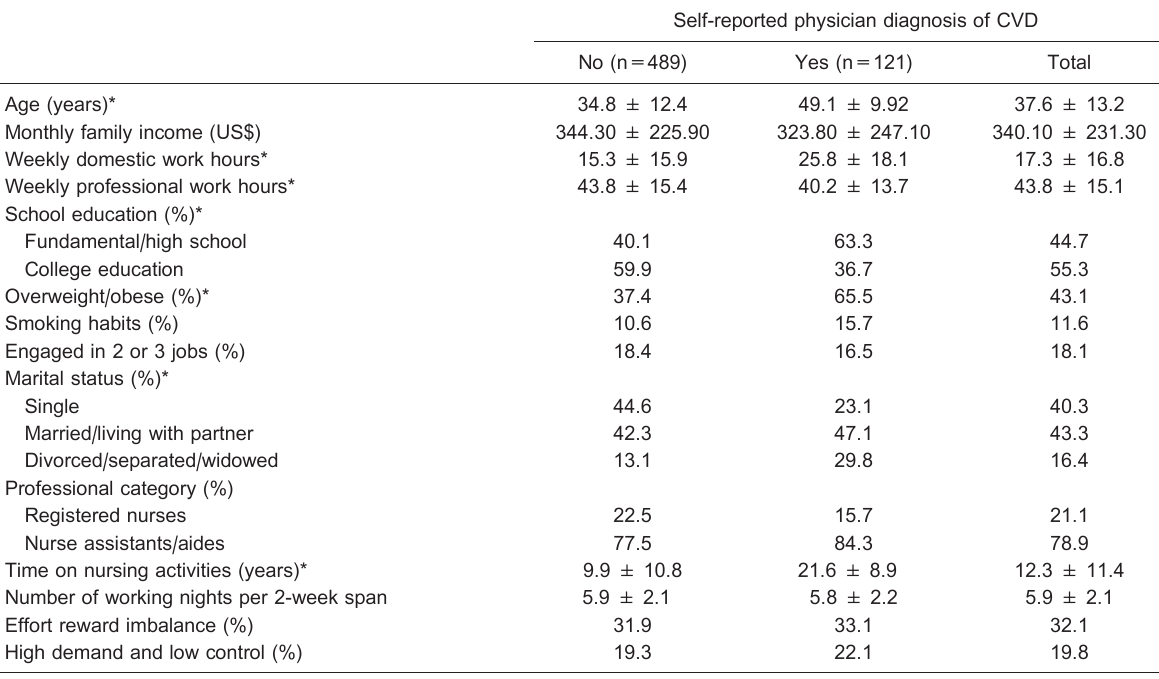
Table 1. Sociodemographics, life style and work characteristics among nursing workers according to the prevalence of self-reported physician diagnosis of cardiovascular diseases